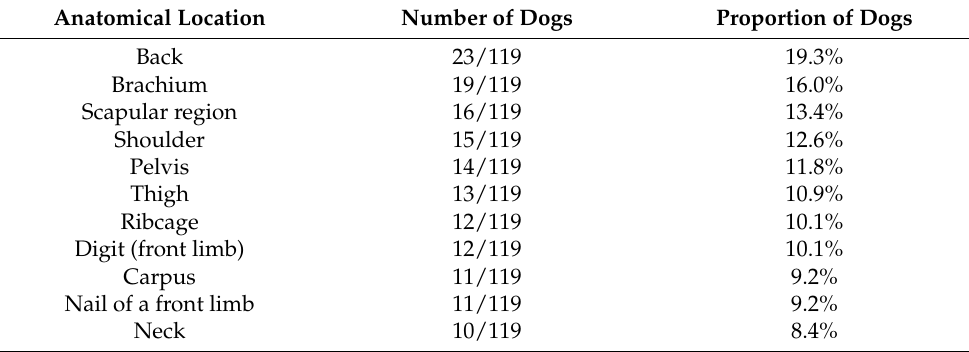
Table 5. Most commonly injured anatomical locations ( n =